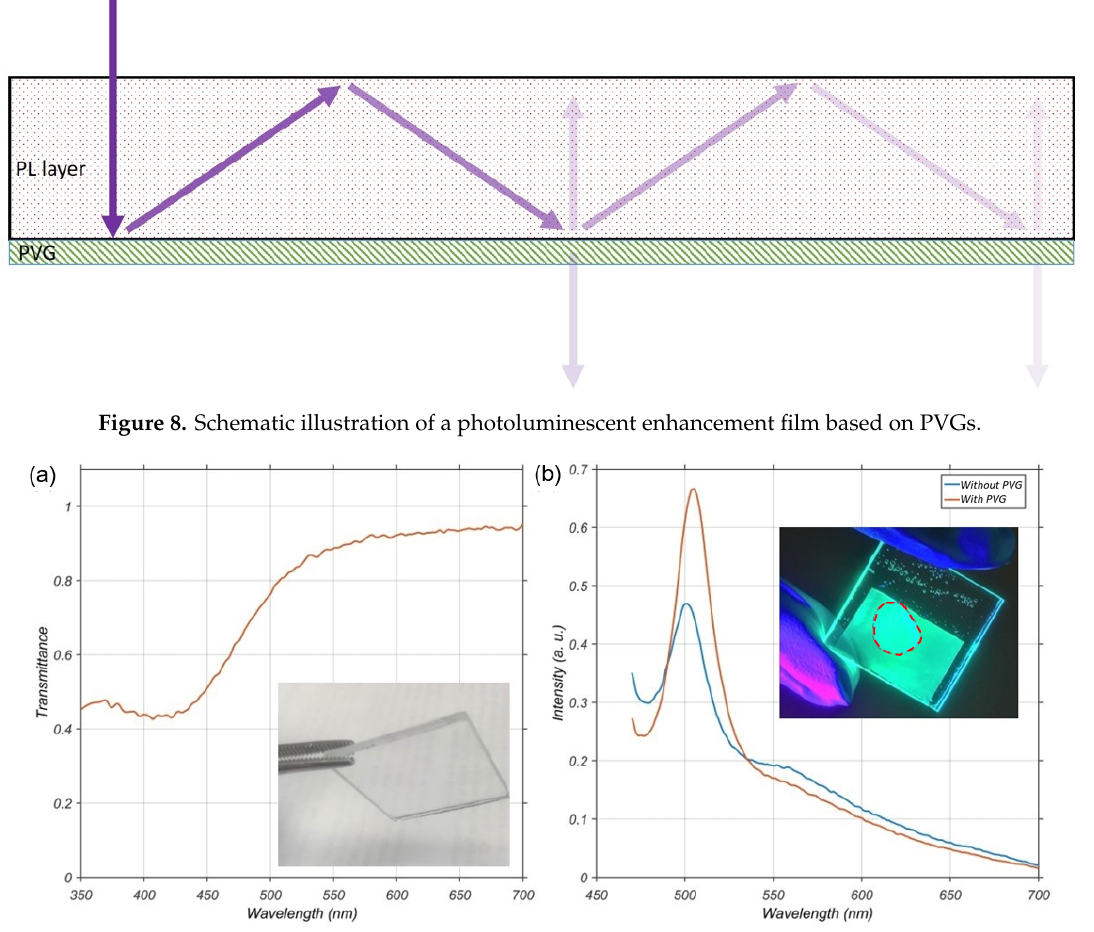
Figure 9. ( a ) Transmittance spectrum of a PVG as the luminance enhancement film. ( b ) Measured PL intensity of a perovskite film with and without the PVG.